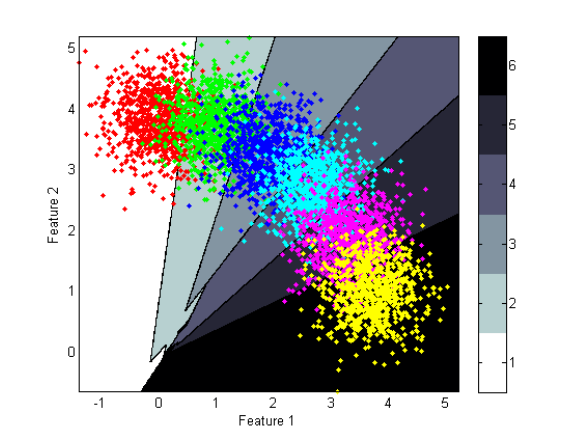
Figure 4: Decision boundaries of the one-vs.-one SVM classifi- cation model for the simulated data set